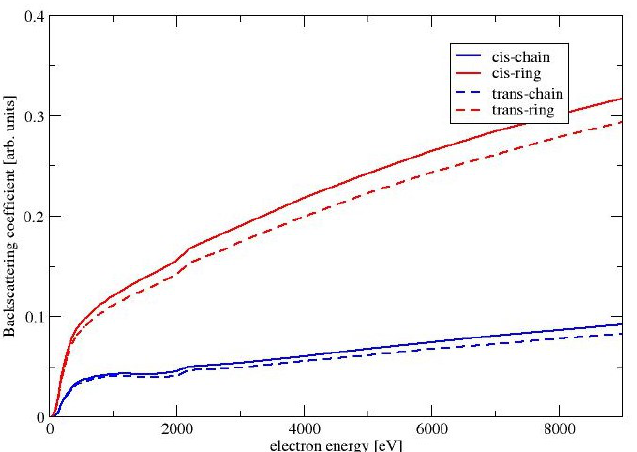
Figure 7. Backscattering coefficient as a function of the electron energy for the conformers of